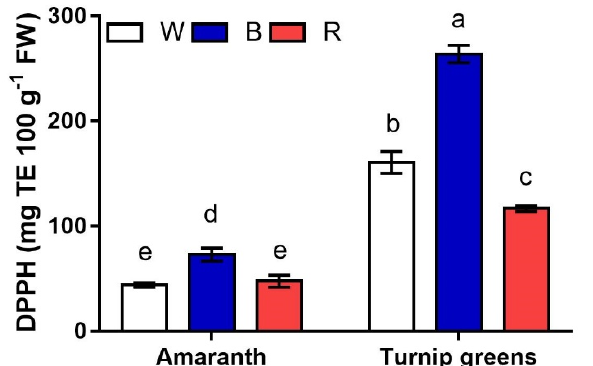
Figure 6. Interaction effect of species × light treatment (W = white, B = blue, R = red) on ascorbic acid (Asc, mg·100 g − 1 FW) of microgreens. Data are means ± standard error ( n = 3). Three biological replicates were used for the analysis. Different letters indicate significance at p ≤ 0.05 according to Tukey’s test.